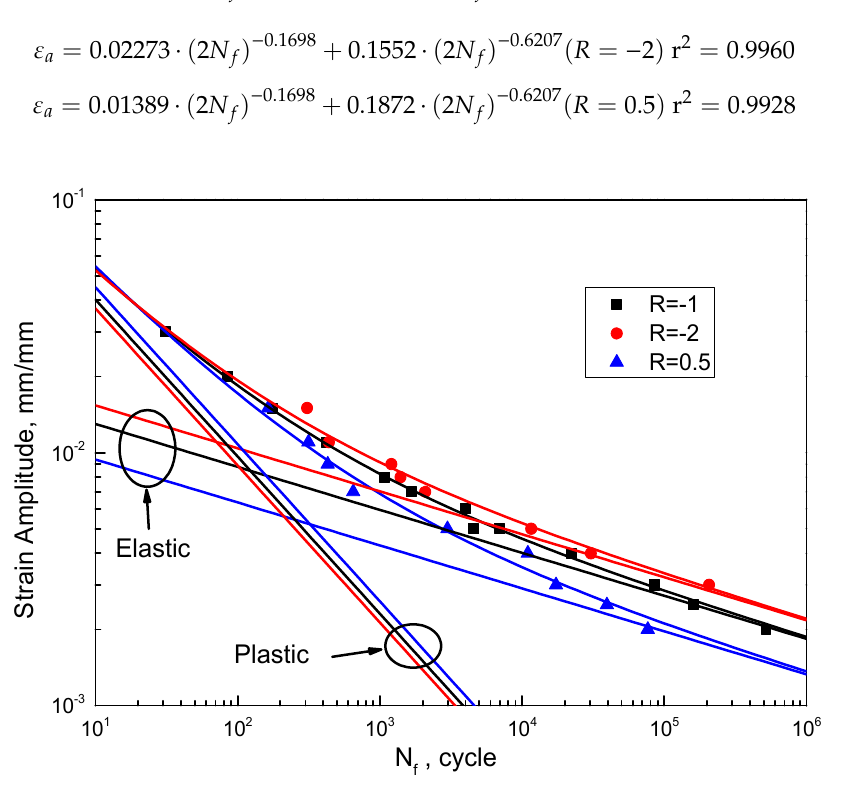
Figure 5. LCF lives of HPTS under different strain ratios.